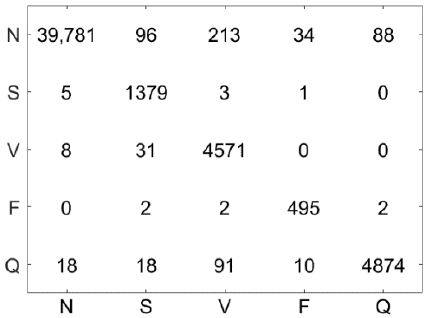
Figure 11. Confusion matrix using the LC-KSVD model.